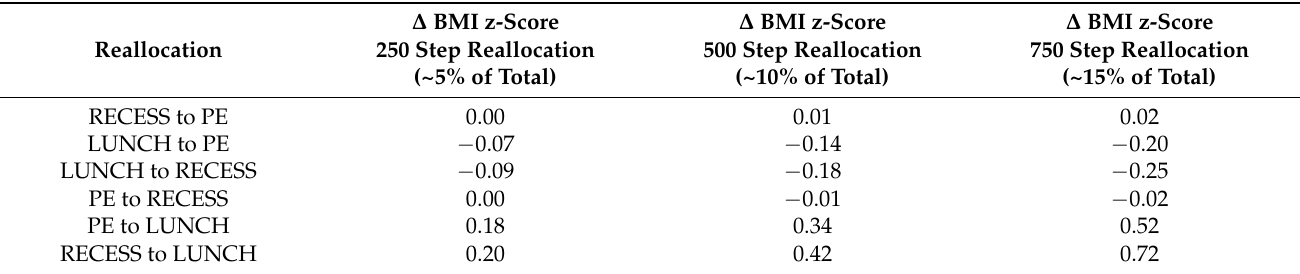
Table 3. Predicted changes in Body Mass Index z-scores following step count reallocation between school day segments using compositional isotemporal substitution.